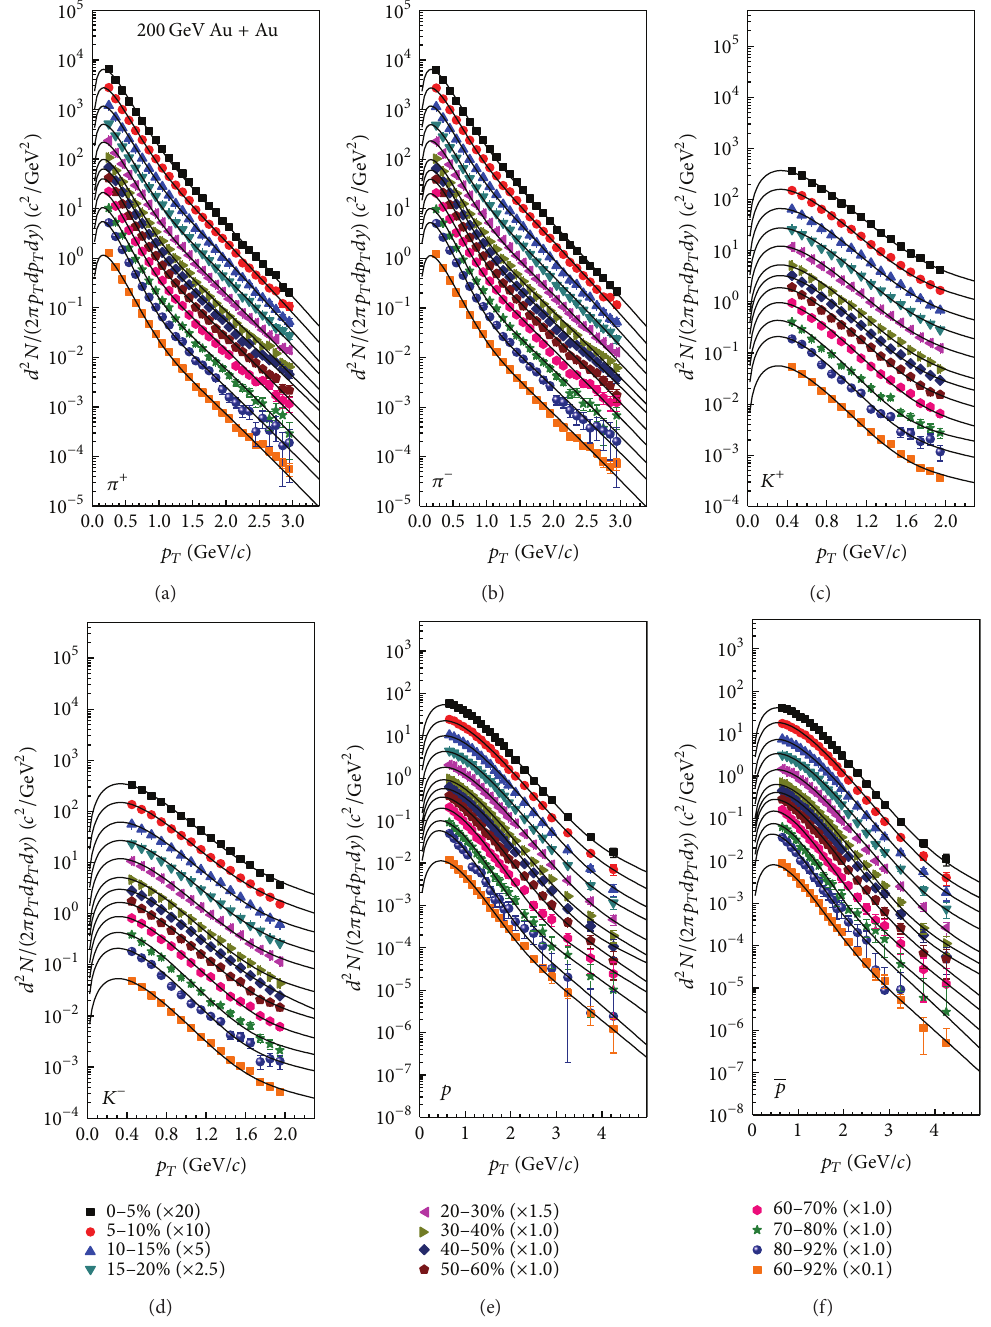
Figure 4: The transverse momentum distributions of negatively and positively charged particles produced in Au-Au collisions at √𝑠 𝑁𝑁 = 200 GeV with different centrality classes and magnifications. The symbols represent the experimental data of the PHENIX collaboration [40], and the curves are our results calculated by the two-component revised Boltzmann